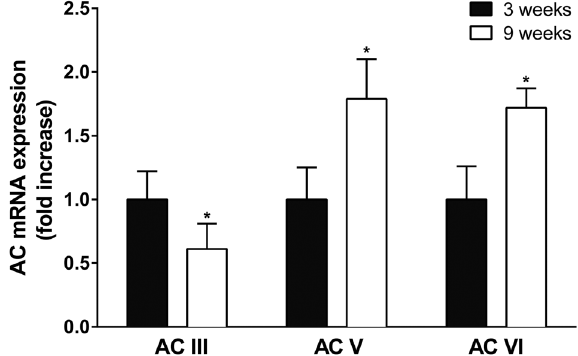
Figure 7. Comparative analysis of transcript abundance of adenylyl cyclase (AC) isoforms. qPCR was performed on cDNA from 3- and 9-week-old rats. The relative expression of AC III, V, or VI was calculated by the 2 - DD CT method and normalized with respect to the mean value of 3-week-old controls. All values were normalized. Data are reported as the mean ± SE of 5 different animals. *P o 0.05 vs 3-week-old rats (one-way ANOVA followed by Newman Keuls test).